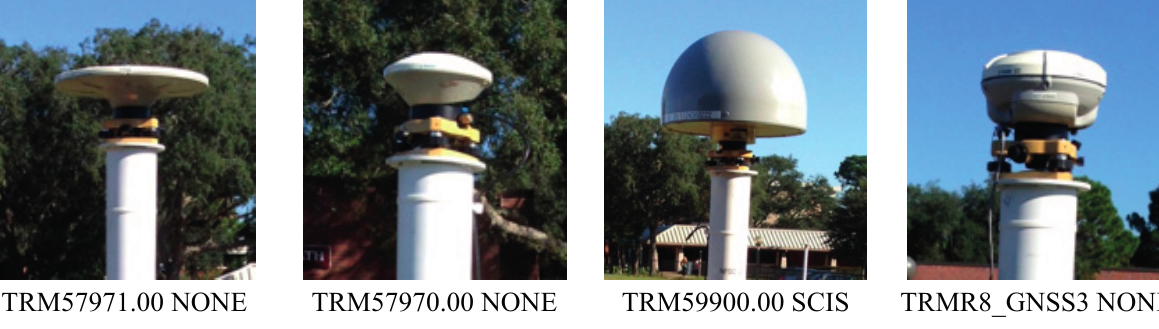
Figure 5. Antennas used in Phase 1